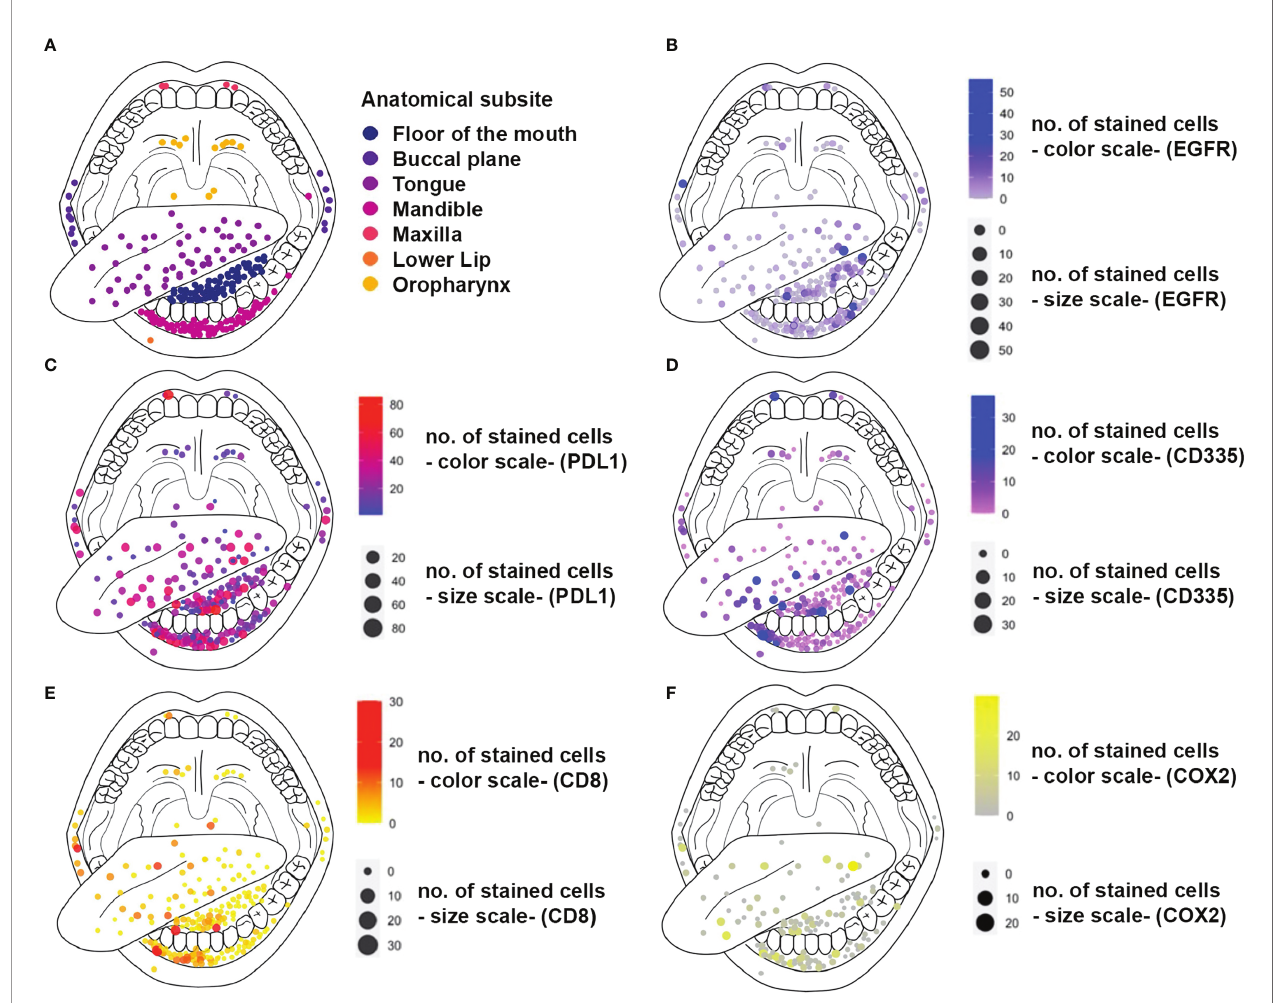
FIGURE 2 | Anatograms of immunostains for different biomarkers. Diameter and color of dots represent the number of stained cells for each biomarker. The localizations of dots meet the anatomic subsites affected by the tumor. (A) Localization of tumor tumors within the oral cavity and the oropharynx (B) EGFR expression (C) PD-L1 expression (D) CD335/NK cell In fi ltration (E) CD8 cell in fi ltration (F) COX2